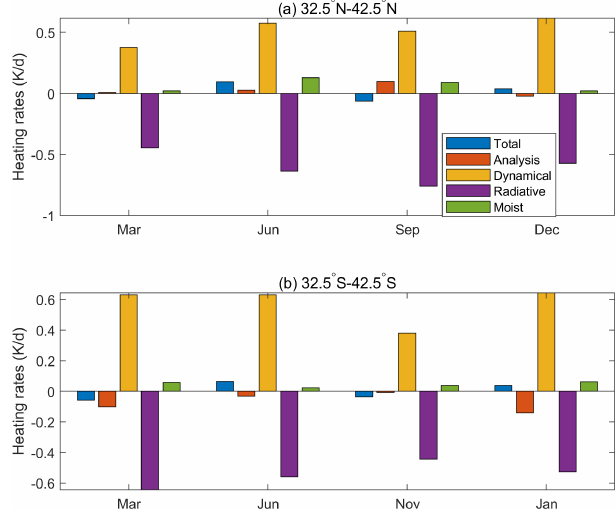
Figure 5. The variation of heating rates terms at 200hPa at peaks and troughs of the total heating rates around the NHM 32.5– 42.5 ◦ N (a) and the SHM 32.5–42.5 ◦ S (b) based on MERRA2 data. The blue, red, yellow, purple and green bars are total, analysis ten- dency, dynamical, radiative and moisture terms, respectively.